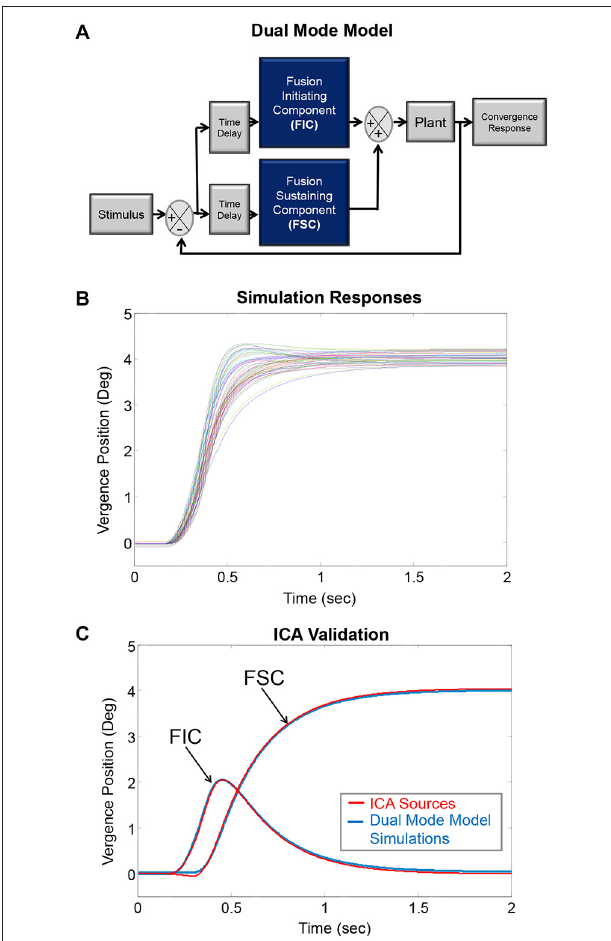
FIGURE 1 | (A) The Dual-Mode model describing vergence as preprogrammed with feedback controlled subcomponents termed the fusion initiating component (FIC) and fusion sustaining component (FSC), respectively. These components lead into the plant, which represents mostly the extraocular muscles. (B) This model generated simulated convergence responses to 4 ◦ symmetrical steps where each colored trace represents a convergence eye movement. These simulated responses are similar to experimental data. (C) The simulated responses had known underlying sources. The average FIC and FSC from the known sources shown in plot (B) are plotted in blue (labeled using arrows). The ICA algorithm computed two sources plotted in red. The known simulation sources and the ICA sources are similar; validating ICA can be used to dissect experimental convergence responses into their underlying FIC and FSC